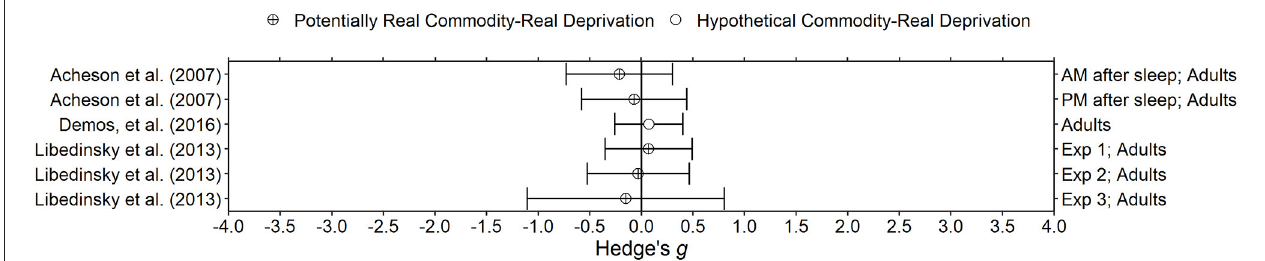
FIGURE 6 | Effect sizes for sleep deprivation experiments. Effect size is Hedge’s g . Points closer to 0 indicate smaller effect sizes. Points to the right of the line indicate increases in delay discounting due to deprivation, the predicted effect. Circles with a cross indicate that the delay discounting task used potentially real outcomes and subjects experienced real deprivation. Unfilled circles indicate that the delay discounting task used hypothetical outcomes and subjects experienced real